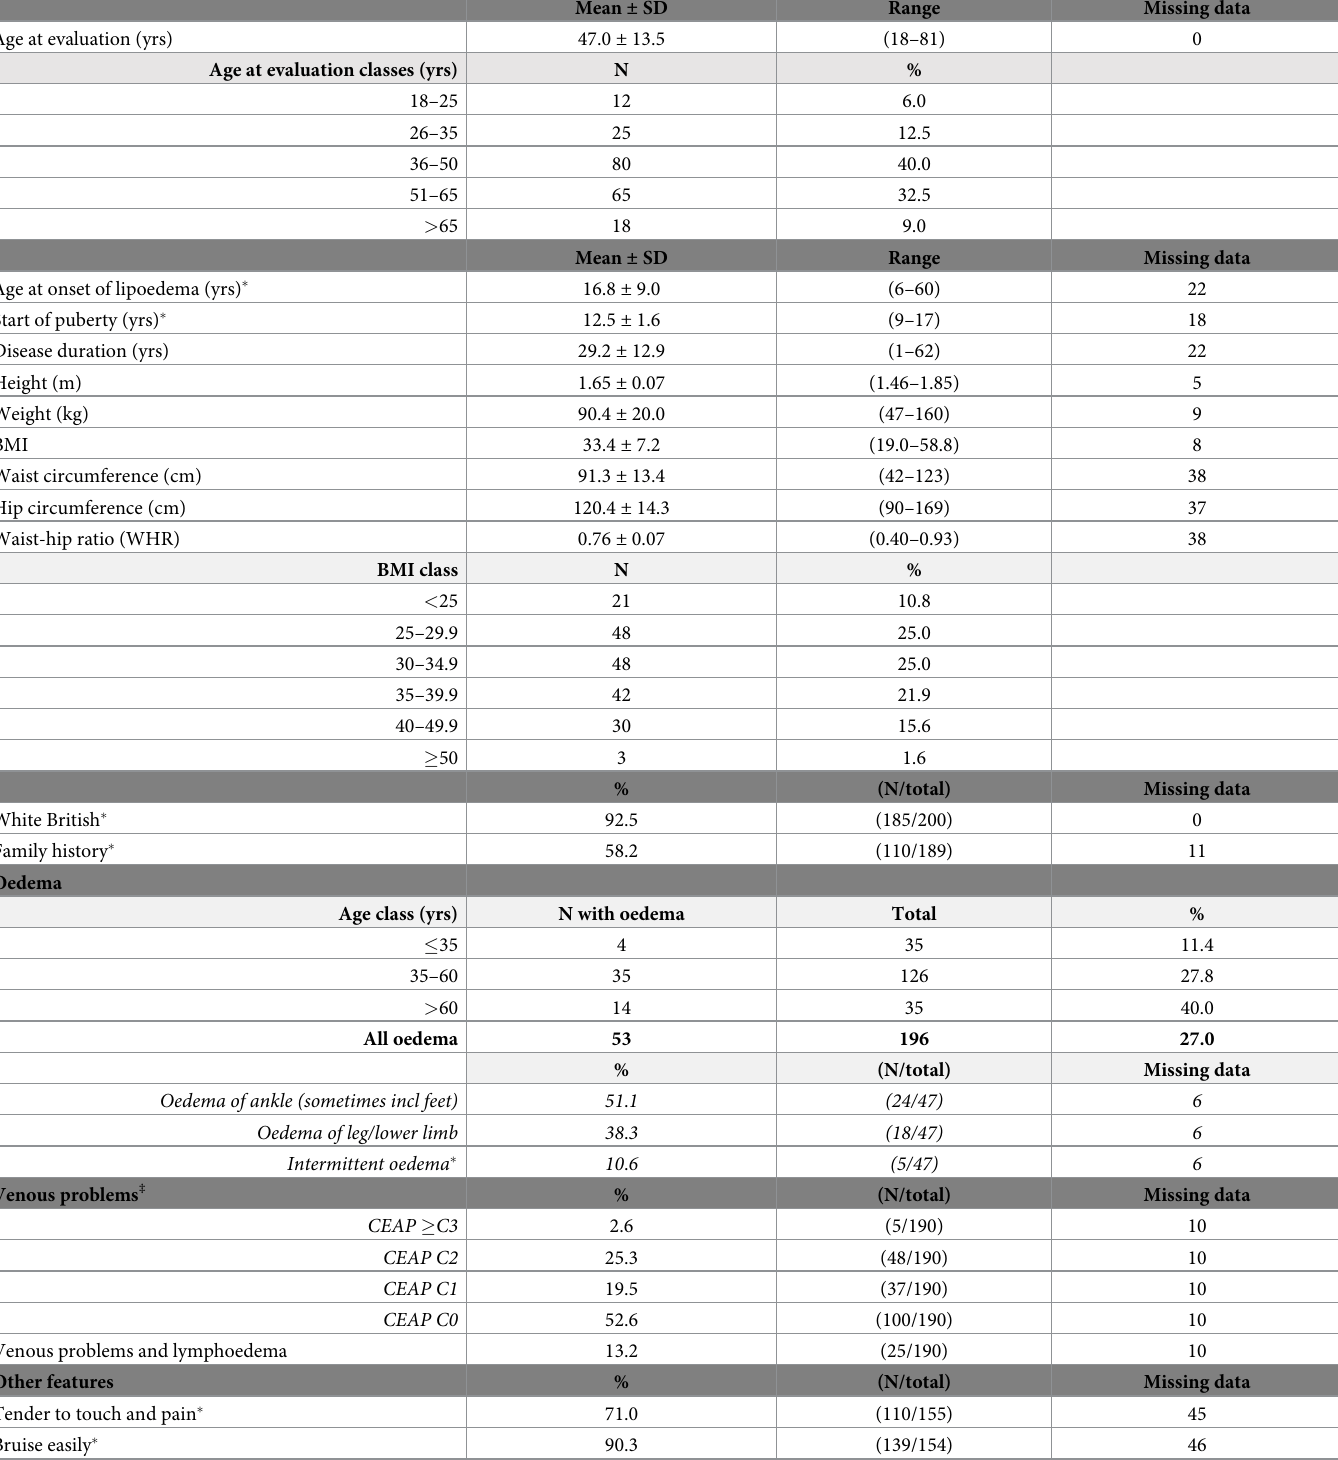
Table 2. Summary characteristics of the ‘UK Lipoedema’ cohort. Observations from the clinical examination and information obtained through face-to-face interview at time of recruitment is included. A total of 200 individuals were recruited to the study. ‘Missing data’ indicates the number of individuals where values were not